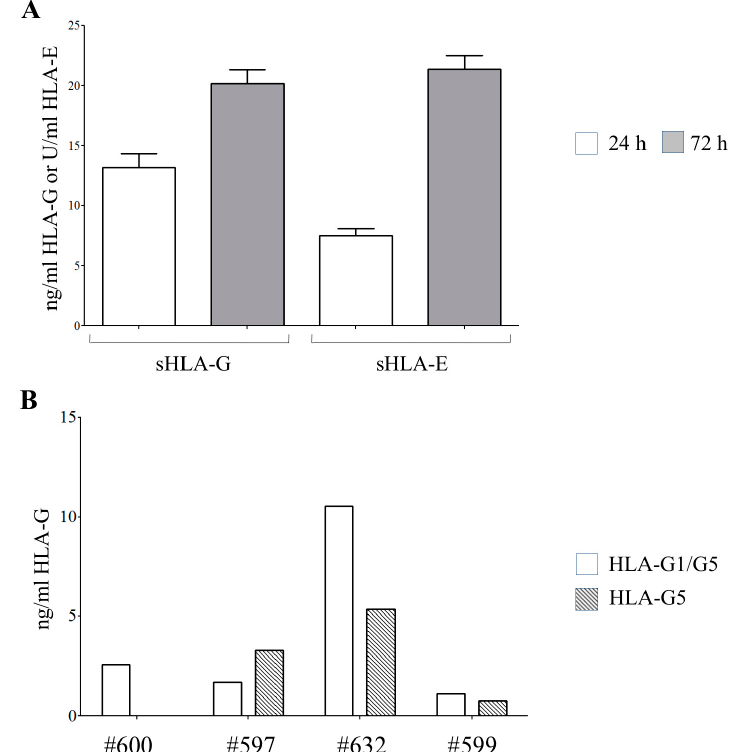
Figure 2. Release of HLA-class Ib molecules by hAECs. ( A ) Soluble (s) HLA-G and -E molecules were quantified by ELISA in supernatants from 6 different batches of hAECs, collected after 24 h (white columns) or 72 h (grey columns) of culture. Results are expressed as ng/mL (sHLA-G) or units/mL (sHLA-E). ( B ) sHLA-G1/G5 and sHLA-G5 were quantified by ELISA in 4 random different batches of